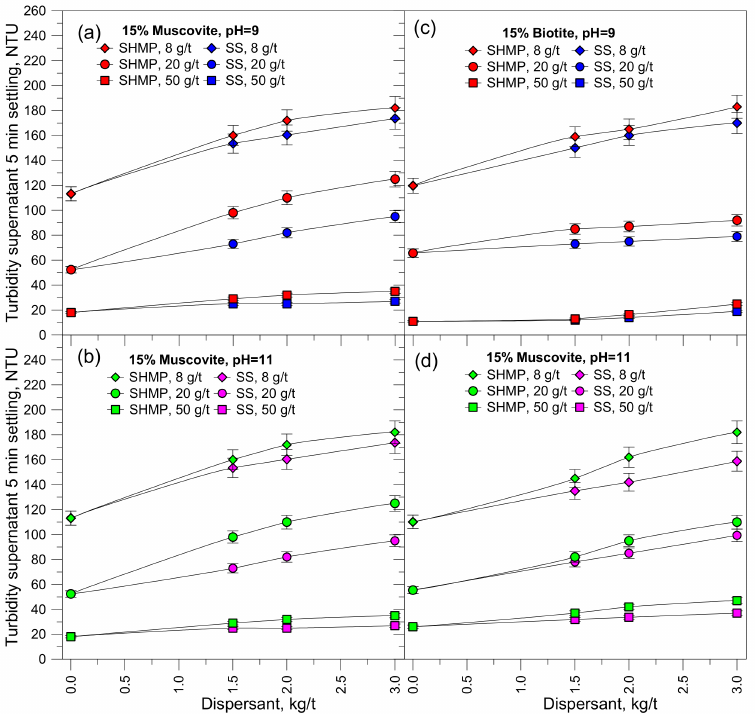
Figure 10. Turbidity of supernatant measured after 5 min of tailing settling as a function of dispersant additions in the flotation